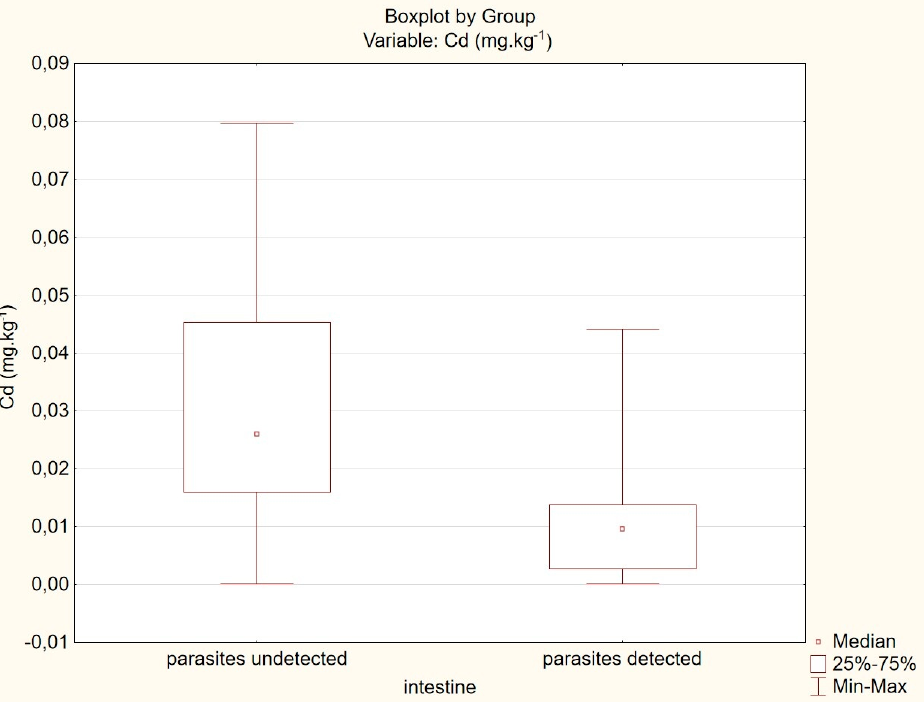
Figure 1. Association between prevalence of parasites and Cd content in fox intestines.